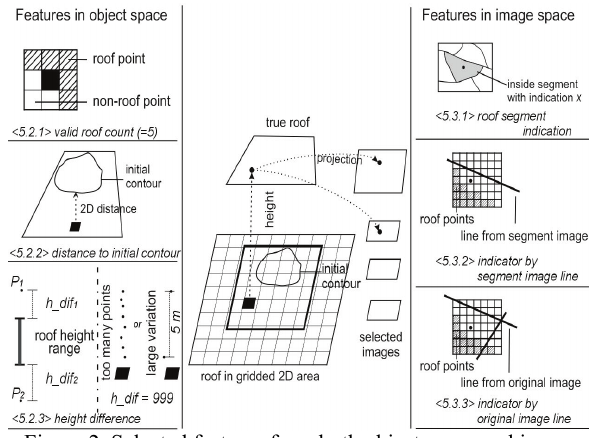
Figure 2. Selected features from both object space and image space used for roof